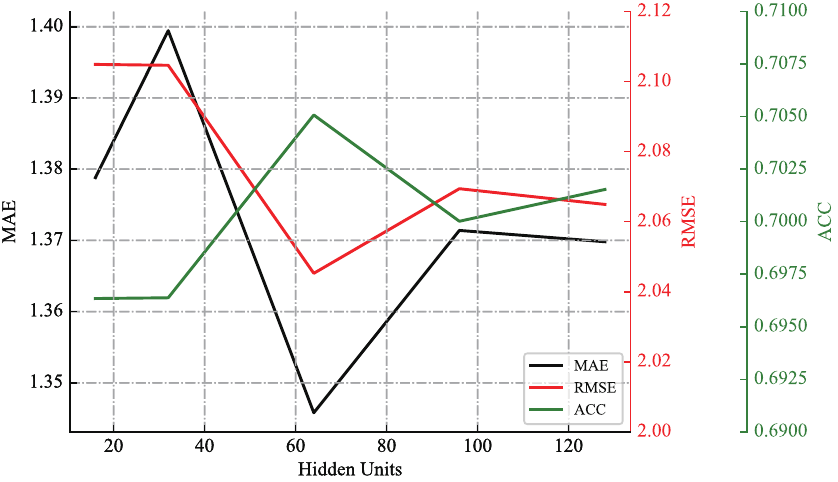
Figure 5. The comparison of predicted performance under different hidden units in the ATFPNet.